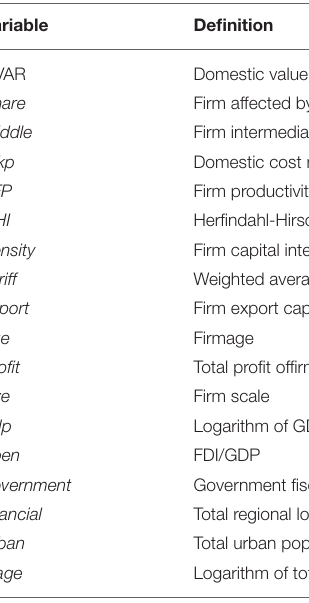
TABLE 1 | Descriptive statistics of